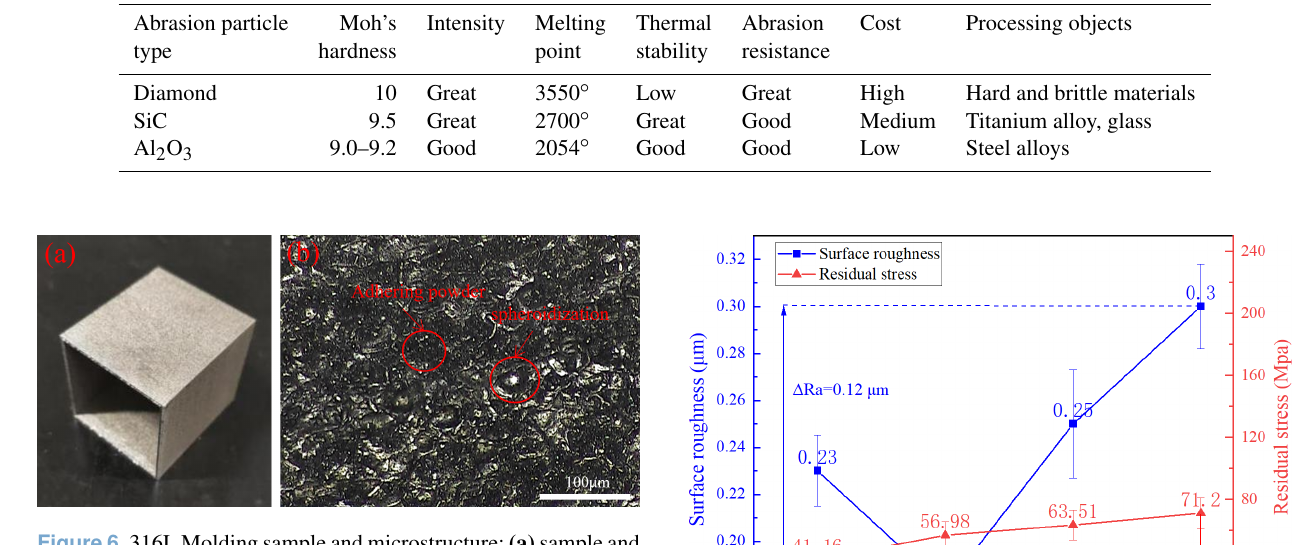
Figure 6. 316L Molding sample and microstructure: (a) sample and (b) micromorphology.